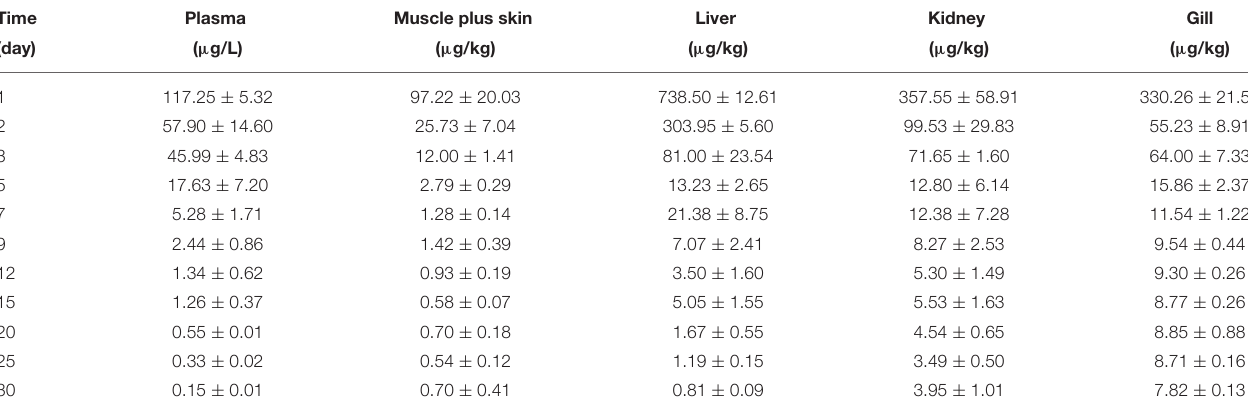
TABLE 3C | The tiamulin concentrations in plasma and tissues of Nile tilapia after daily oral administration of a single dose of 20 mg/kg for 5 days at 30 ◦ C ( n = 6). Time Plasma Muscle plus skin Liver Kidney